Question: What visual encoding does this figure use to show its data?
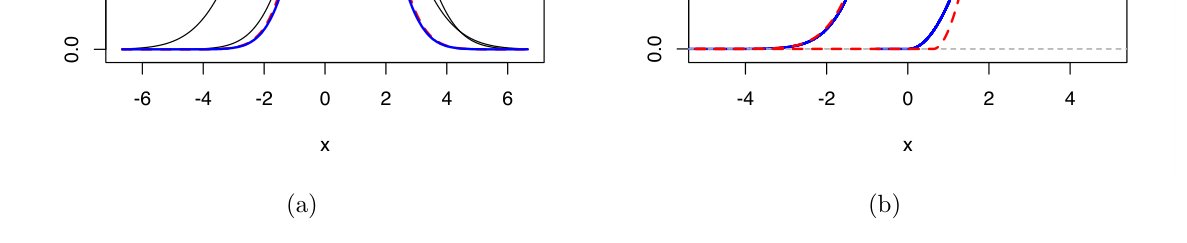
Answer: line